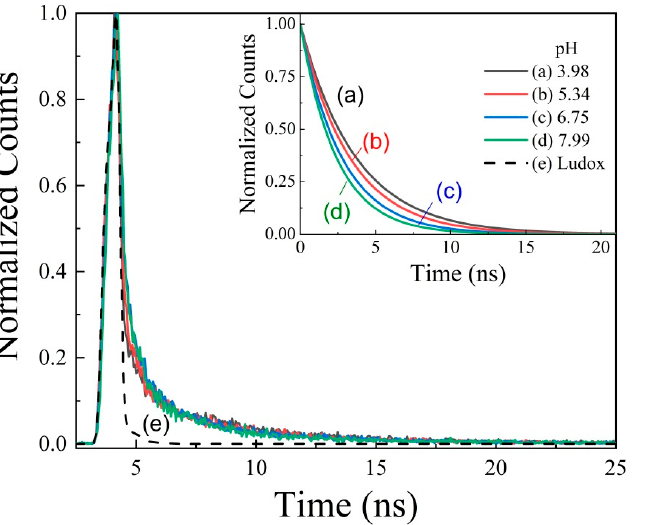
Figure 6. Decay of fluorescence for natural dye that was extracted in different values of pH (a) 3.98, (b) 5.34 (c) 6.75, and (d) 7.99. The values that were obtained for τ were (a) (3.7 ± 0.1), (b) (3.3 ± 0.1), (c) (2.7 ± 0.1), and (d) (2.4 ± 0.1) ns. The decay for Ludox is presented in (e). (c) (2.7 ± 0.1), and (d) (2.4 ± 0.1) ns. The decay for Ludox is presented in